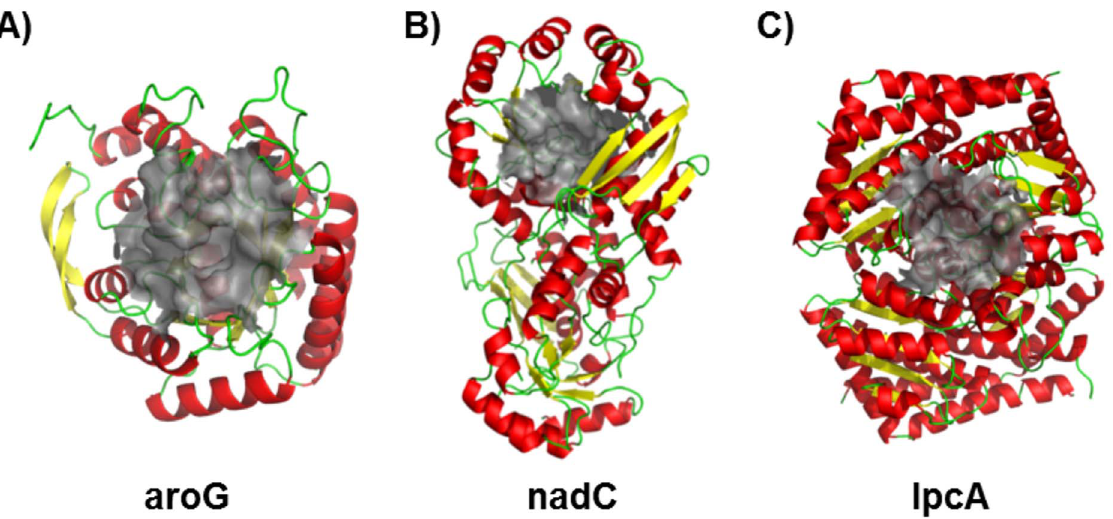
Figure 2. Crystal structures determined in this work. Crystal structures for aroG (A), nadC (B), and lpcA (C) color coded according to their secondary structure elements, with the active site region used in structure-based virtual screening shown as a gray surface.